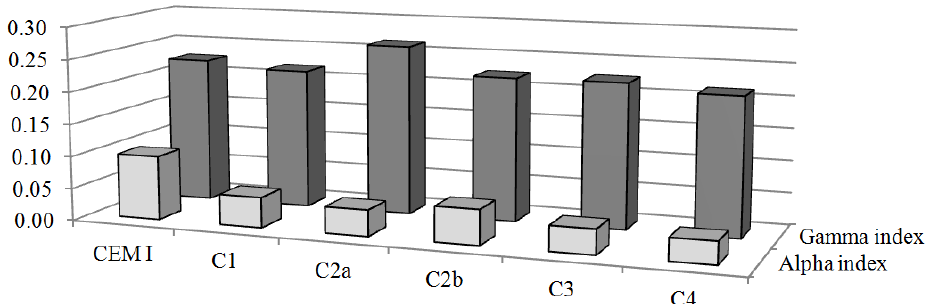
Figure 3. Comparison between the average values of gamma and alpha index of cement (used in composites) and cement